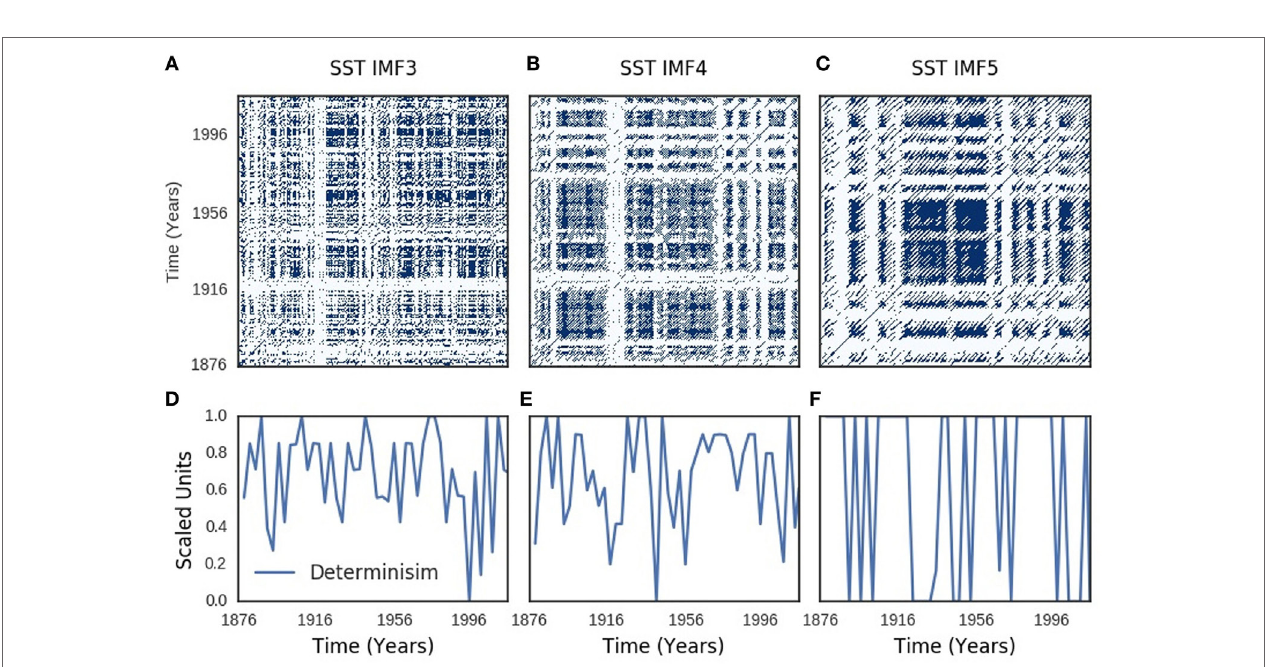
FigUre 5 | Sea surface temperature (SST) recurrence plots. Recurrence plots shown in (a–c) resemble Lorenz chaotic dynamics. Periodic regimes have long, uninterrupted, even parallel diagonal lines, while quasi-periodic regimes have uneven vertical distances between the diagonal lines. Chaotic regimes have single points and short diagonal lines. Time-varying determinism is shown in (D–F) .